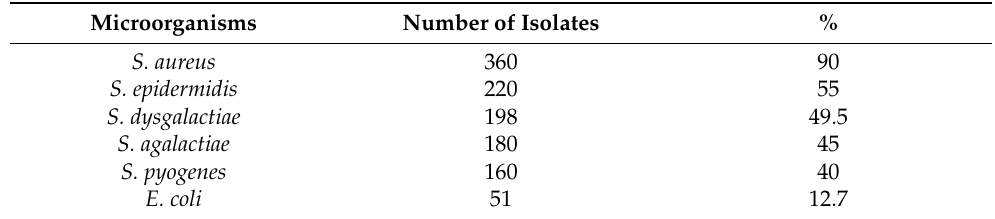
Table 1. Results of microbiological examination of milk samples from 400 cows with serous mastitis. Microorganisms